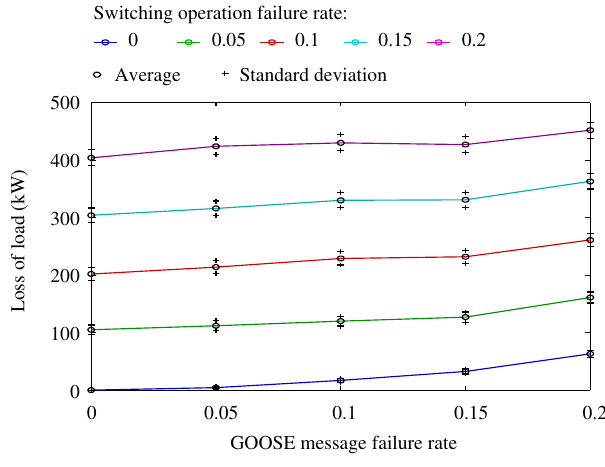
Figure 11. Reliability